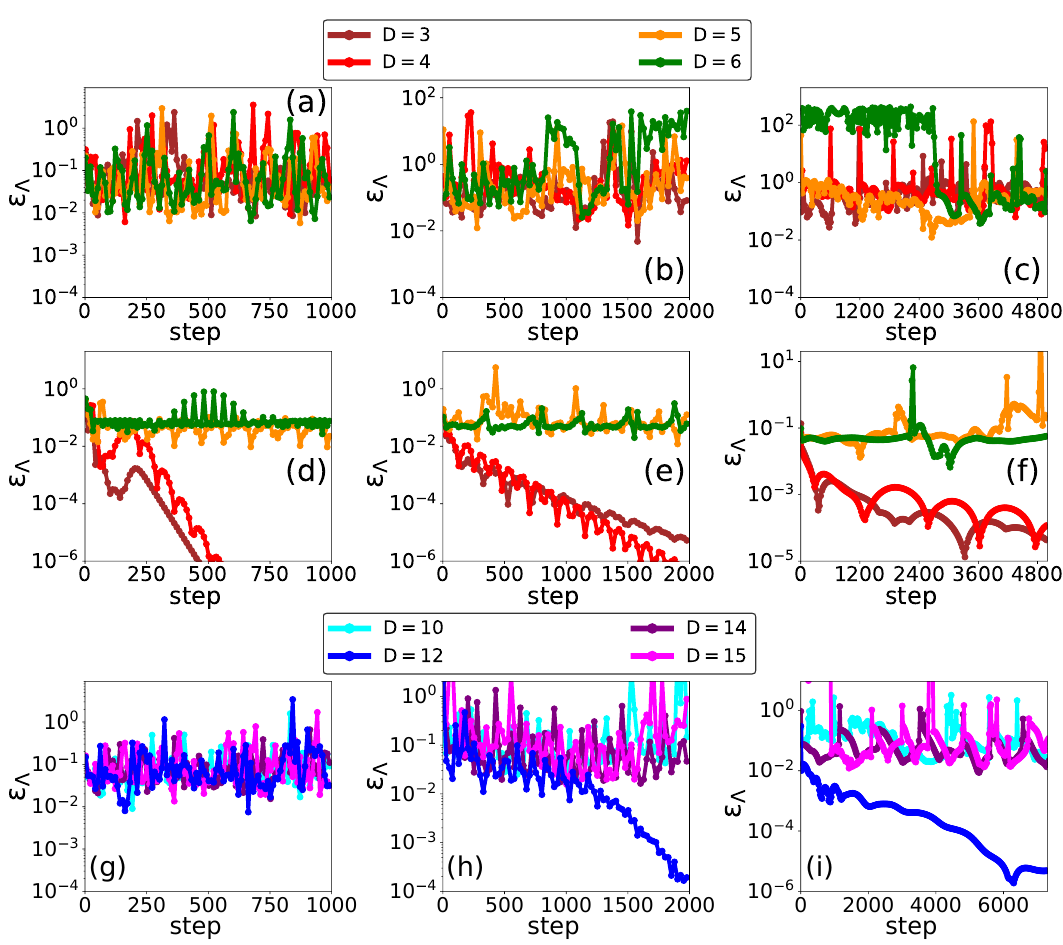
= 1.2 (a-c,g-i) and J = 1.5 (d- y y